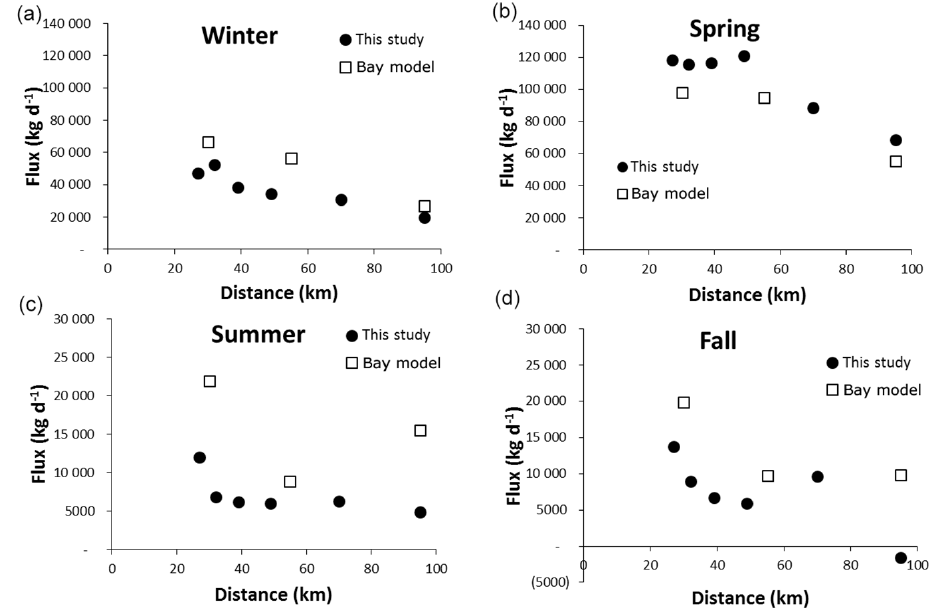
Figure 8. Comparing the TN fluxes along the Potomac River estuary estimated from the box model used in this study and from the results from the Chesapeake Bay nutrient model.